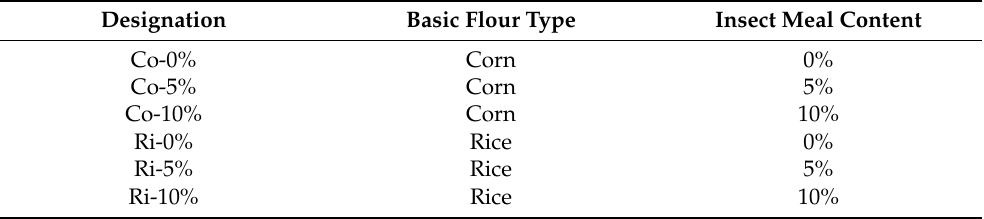
Table 2. Designation of individual mixtures, type and quantity of individual flours used for